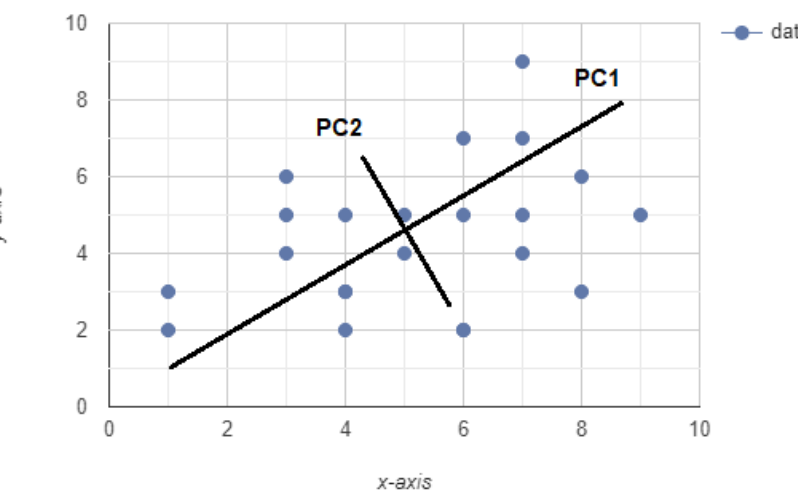
Figure 7. Scatterplot showing an example of PCA analysis generating two principal